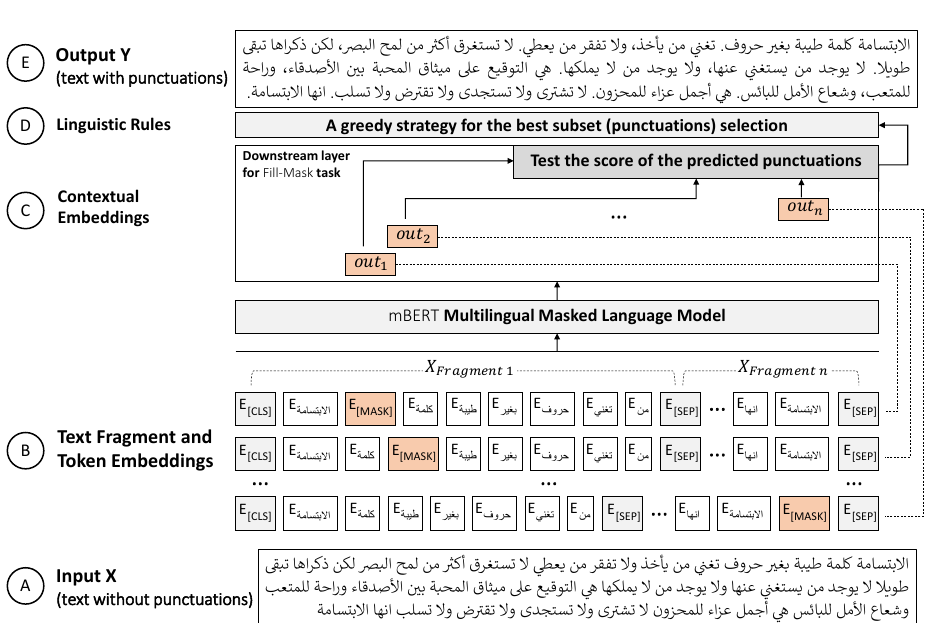
Figure 1. Overview of our proposed PDTS that detects missing punctuations in a complex Arabic text X with the purpose of chunking X into concatenated simple sentences Y . The translation of the mentioned Arabic text X is Smile is the right word without letters. It enriches the one who receives but does not diminish the one who gives. It does not last more than a jiffy to behold, but its memory remains long. No one can do without it, and no one does not own it. It is the signing of the charter of respect between friends, a relief from the tiredness, and a ray of hope for the miserable. It is the most beautiful consolation for the dejected. It is neither purchasable, borrowable, nor lootable. It’s the